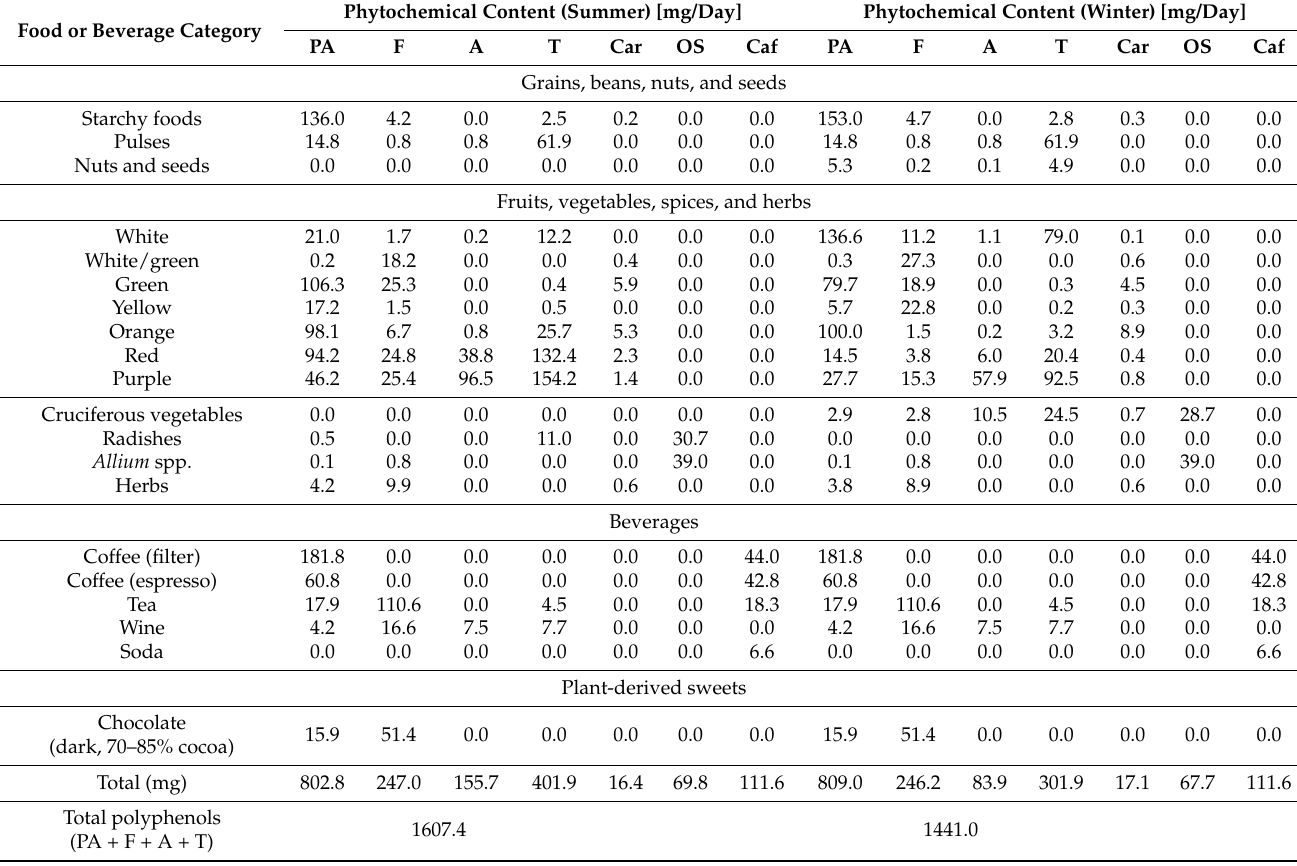
Table 3. Quantity of each phytochemical family (expressed in mg/day) provided by the menus, according to food category. Food or Beverage